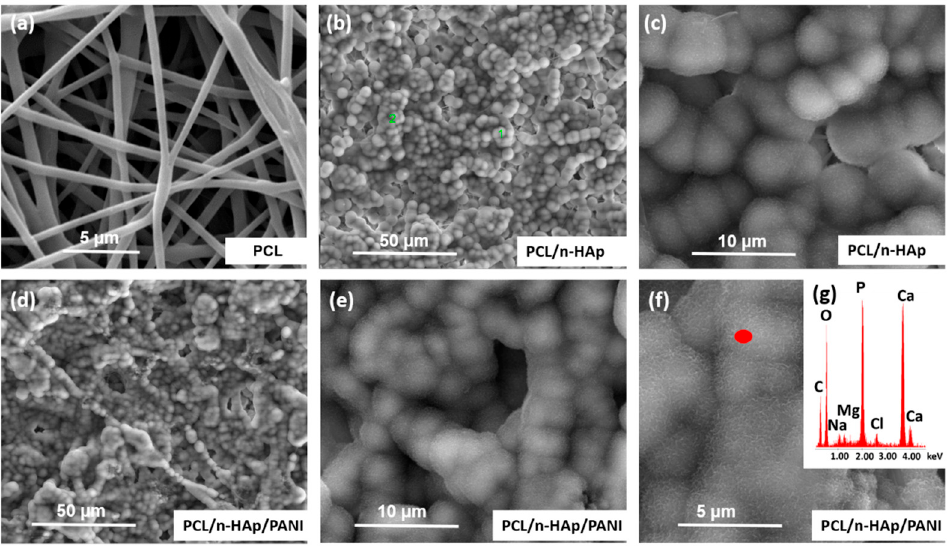
Figure 4. SEM images of: ( a ) PCL, ( b , c ) PCL/n-Hap, ( d – f ) PCL/n-Hap/PANI scaffolds after 14 days of immersion in SBF fluid together with ( g ) EDS analysis.